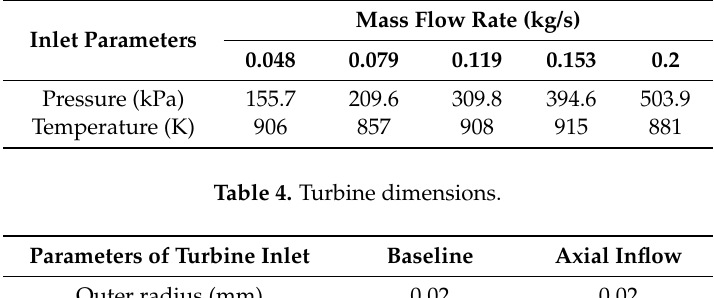
Table 3. Test data used for calculations of VGT boundary conditions.